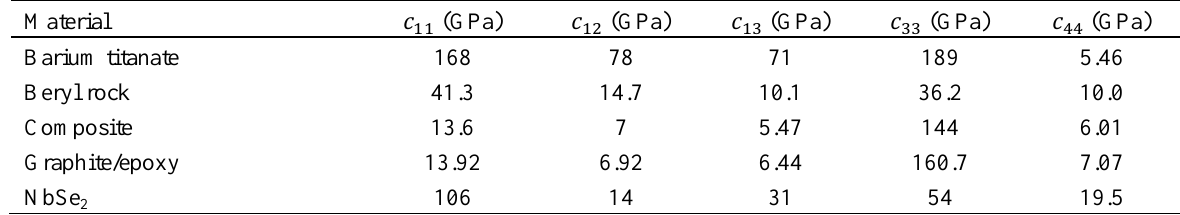
Table 1. Properties of tested